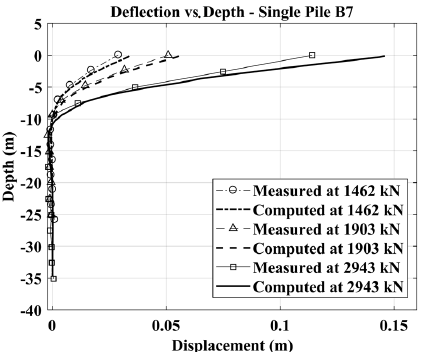
Figure 12. Pile deflections versus depth for B7 single pile under various load levels: Computed data obtained without considering suction.